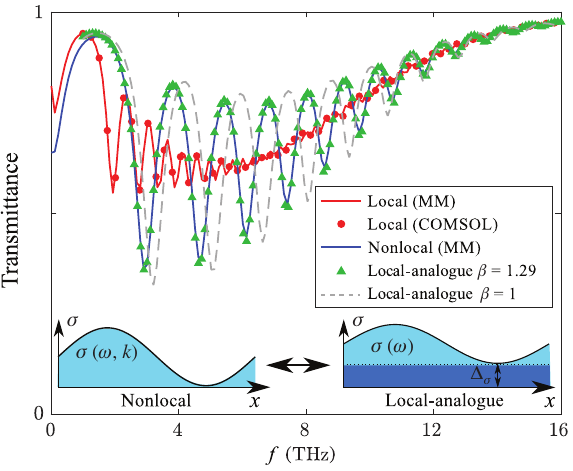
Figure 5: Local (red), nonlocal (blue line), and local-analogue (green triangles for β = 1.29 and gray dashed line for β = 1) transmittance spectra of the singular ( Δ = 3) graphene conductivity grating. The inset shows how a local-analogue metasurface can be obtained by saturating the conductivity of graphene near the value, which causes the local plasmon dispersion to cross the electron dispersion ω = v k , a regime dominated by Landau F